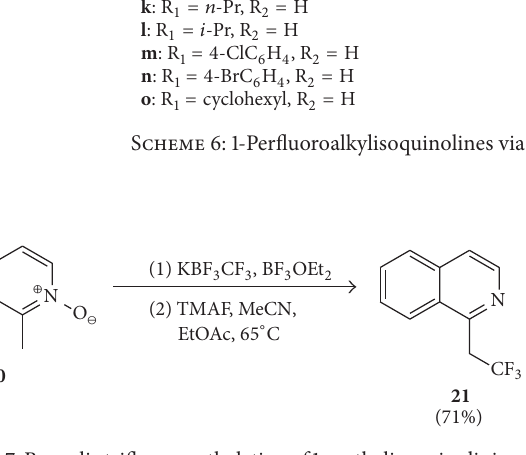
Scheme7:Benzylictrifluoromethylationof1-methylisoquinolinium N